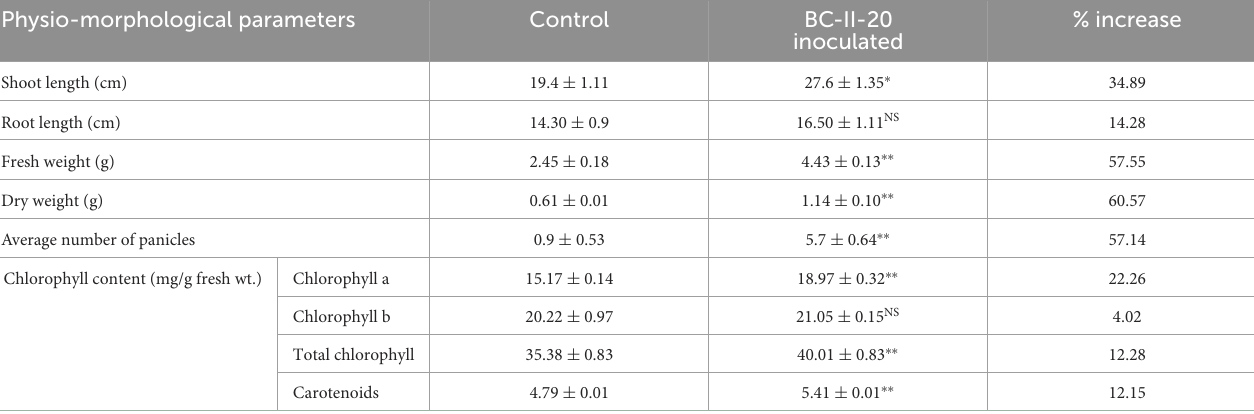
TABLE 3 Effect on different growth parameters of A. paniculata plants treated with bacterial isolate BC-II-20 at the time of harvesting (after ∼ 70 days post germination). Physio-morphological